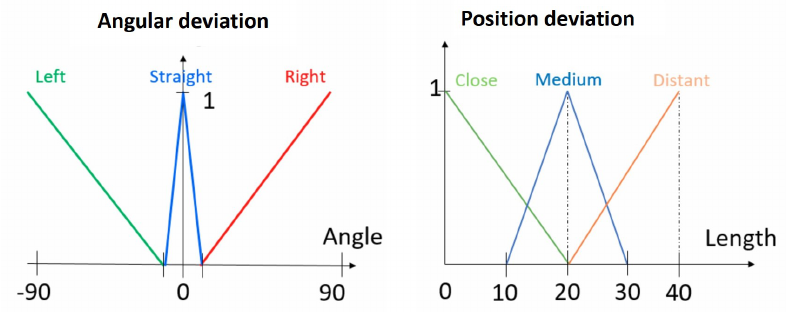
Figure 10. Proposed membership functions for nodes G L , G F , G R ( angular deviation ) and G C , G M , G D ( position deviation ) of the navigation